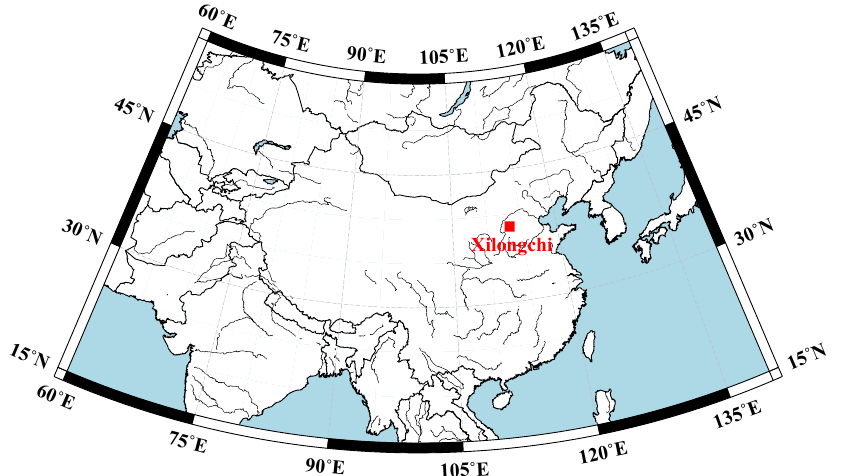
Figure 1. Geographical location of the Xilongchi Reservoir.